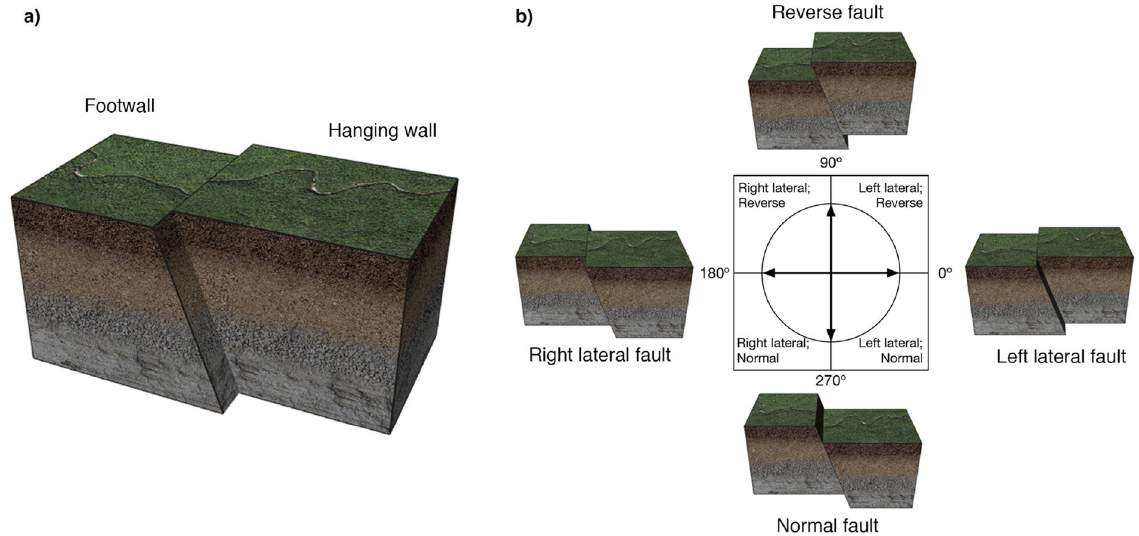
Figure 1. ( a ) An example of a geologic fault used as a stimulus in the experiment. It illustrates a fault plane separating two sections of Earth’s crust, called fault blocks. One of the blocks is labeled as the ‘footwall’ and the other is labeled as the ‘hanging wall’. There is a displacement in rock types on each side of the fault, indicating that the blocks have moved relative to each other. The direction of displacement between blocks is referred to as the rake angle. ( b ) Faults can be categorized according to their rake angle, with four ‘prototypical’ fault ◦ categories illustrated. A left lateral fault ( 0 rake angle) has the hanging wall shifted laterally (to the left) relative ◦ to the footwall. A reverse fault ( 90 rake angle) has the hanging wall elevated relative to the footwall. A right ◦ lateral fault ( 180 rake angle) has the hanging wall shifted right relative to the footwall. A normal fault ( 270 angle) has the hanging wall sunken relative to the footwall. Note that fault categories are partially overlapping; ◦ a fault with 30 rake angle would be categorized as both a left lateral and a reverse fault. (Figure generated using Adobe Illustrator 2021 and Adobe Photoshop 2021).